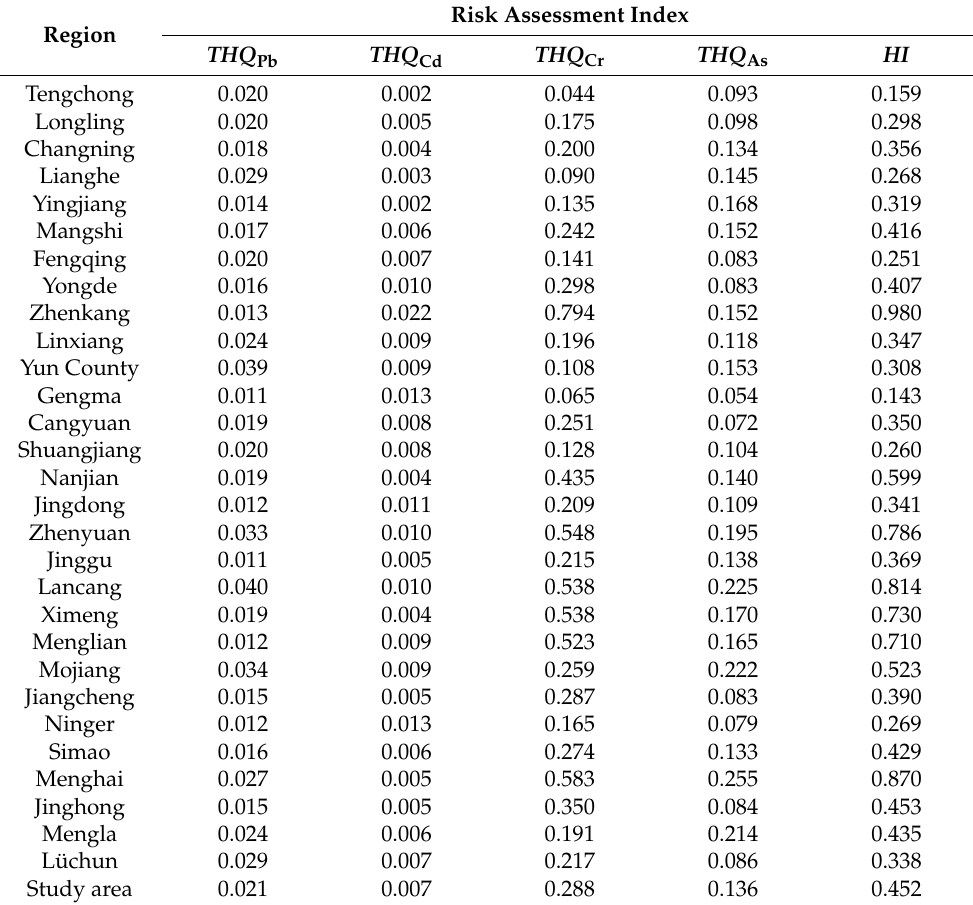
Table 2. The calculated target hazard quotients ( THQ ) of Pb, Cd, Cr, and As, and hazard index ( HI ) for adults associated with the tea leaves consumption in the southwest region of Yunnan province, China. Region THQ Pb THQ Cd THQ Cr THQ